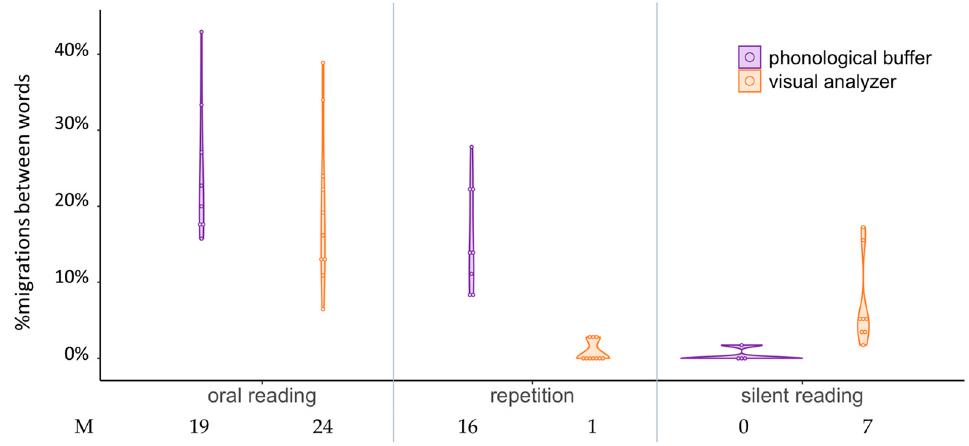
Figure 3. Percentages of migrations between words in word pairs in oral reading, silent reading (semantic decision) and repetition in the two groups.